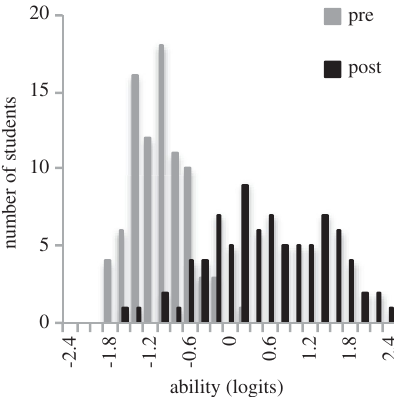
FIG. 19. The pre- and postability histogram for class 5.